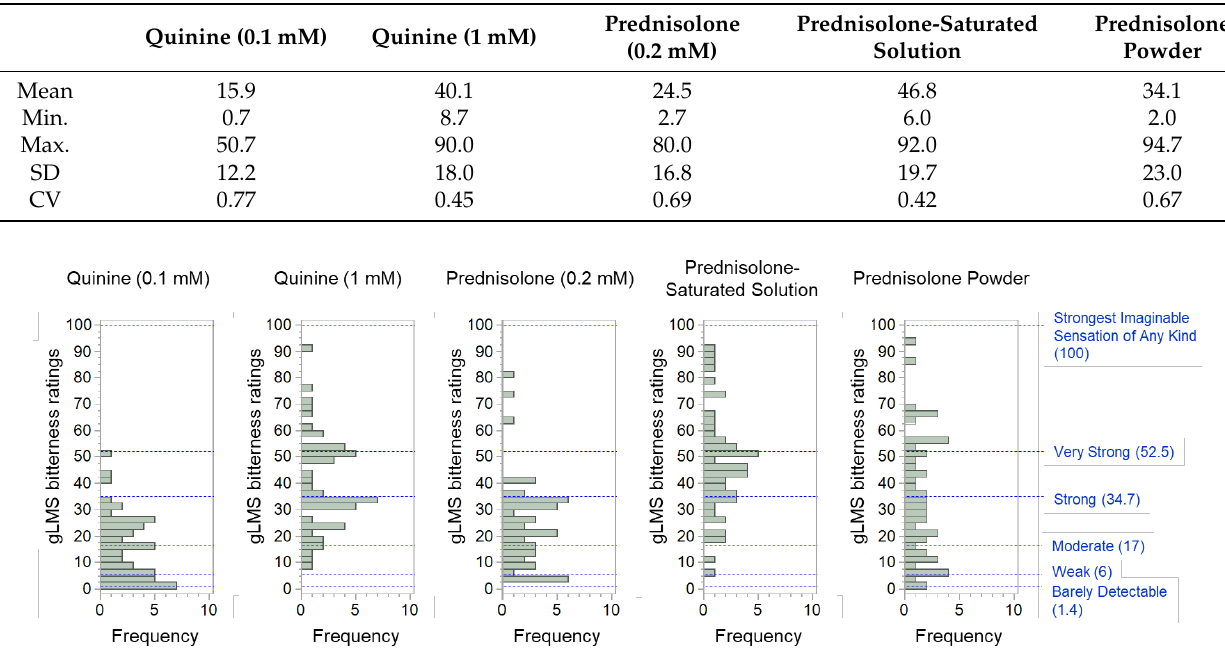
Figure 2. Patterns of subjects’ bitterness perception.